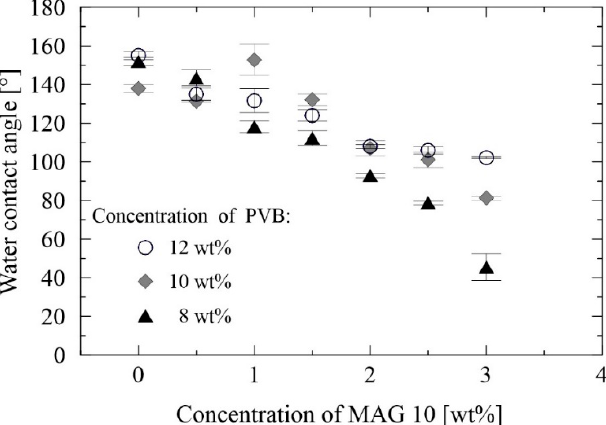
Figure 7. Wettability of the neat PVB and PVB modified with MAG 10.